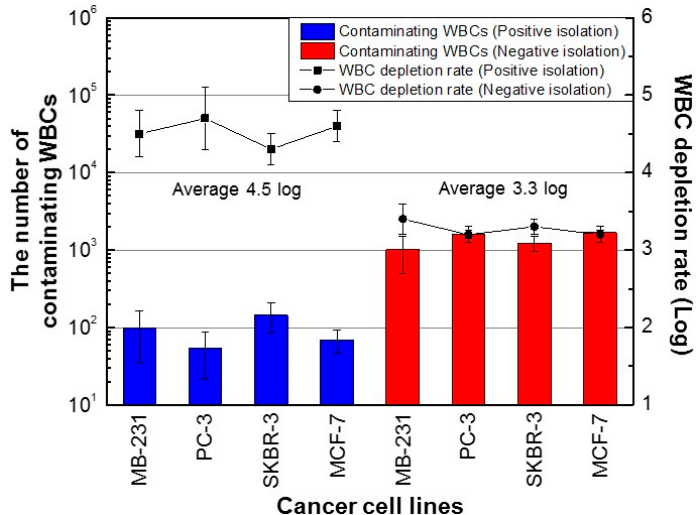
Figure 4. Number of contaminating WBCs using the PosCTC- µ Chip and the NegCTC- µ Chip from 500- µ L blood samples spiked with CTCs. Data are means of triplicate determinations.